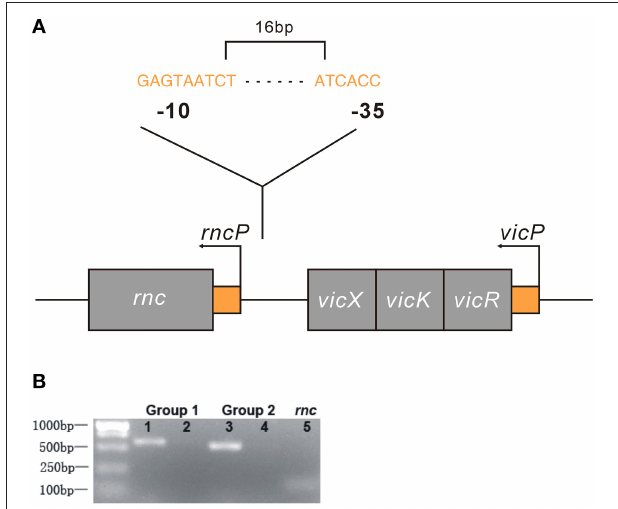
FIGURE 4 | Genetic analyses of the rnc and vicRKX gene loci. (A) Predicted genetic structure of rnc and vicRKX loci by FGENESB and BPROM. The fragment shown was from the S. mutans chromosome, which contained the intact rnc, vicX , vicK, and vicR genes, shown from left to right. The entire sequence was known for this region. Arrows indicated the initiation sites for the vicP and rncP promoters. The supposed sequences of -10 and -35 boxes in rncP were GAGTAATCT and ATCACC, respectively. (B) PCR of rnc and vicX co-transcription assays. Two sets of specific PCR primers were used for the co-transcription assay. Lanes 1 and 3 were used for UA159 DNA, and lanes 2 and 4 were used for UA159 cDNA, which was reverse transcribed from RNA. Line 5 was used as a reference to verify the feasibility of the cDNA.